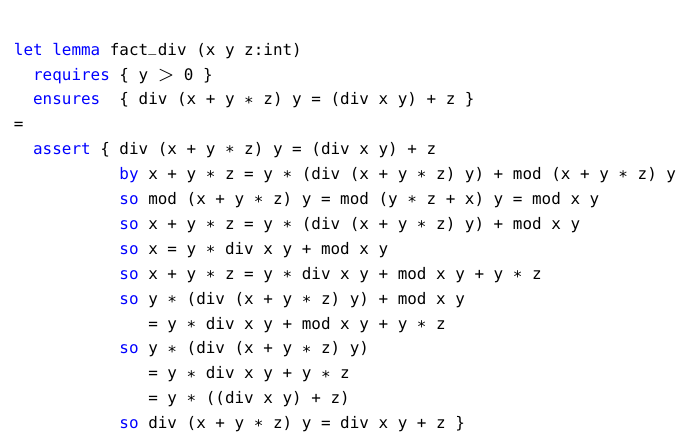
Fig. 6. A Why3 proof using a large assertion.